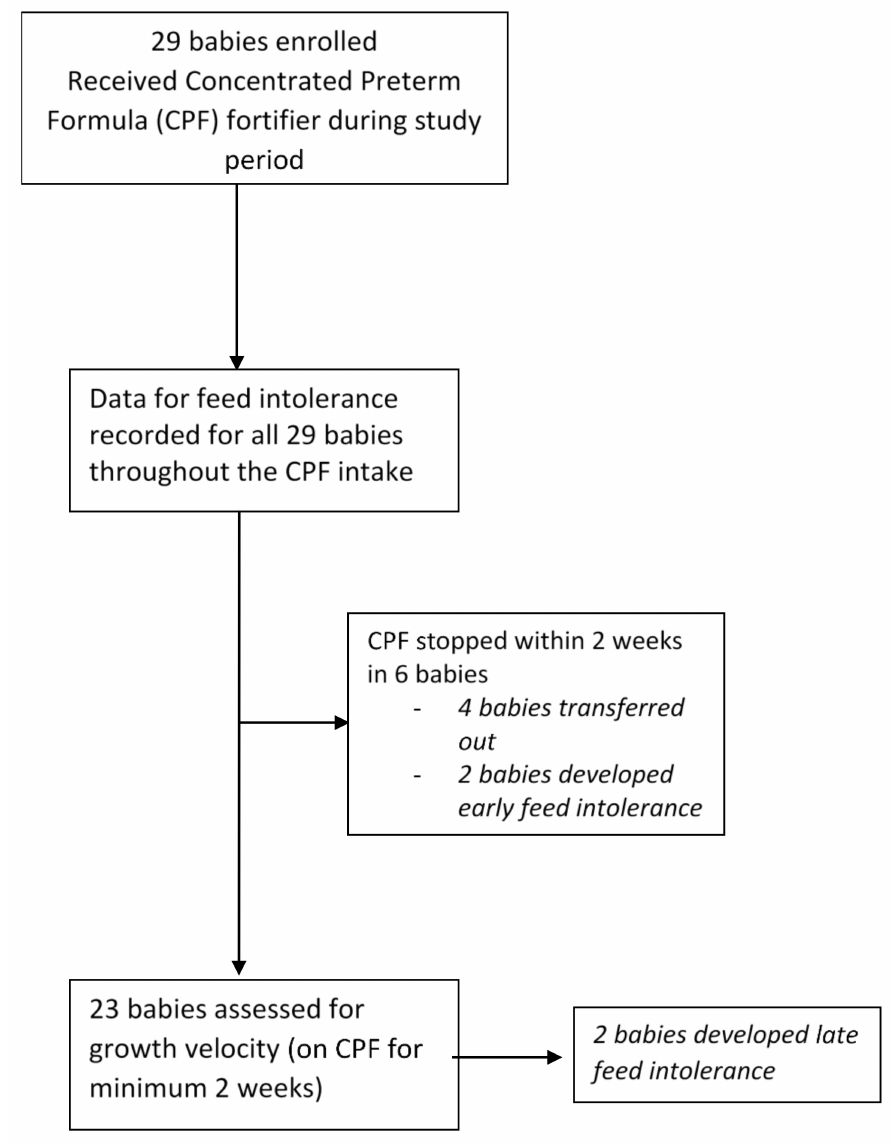
Figure 1. Flowchart of study